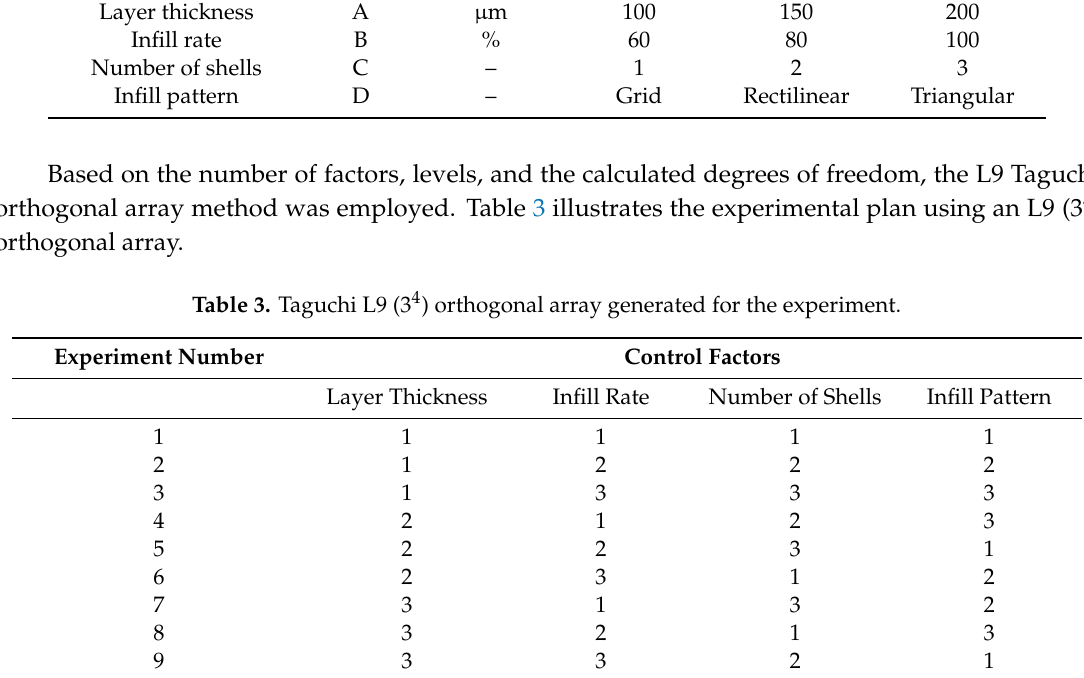
Table 2. FFF PEEK 3D printing process parameters and levels selected for the experiment. Process Parameter Symbol